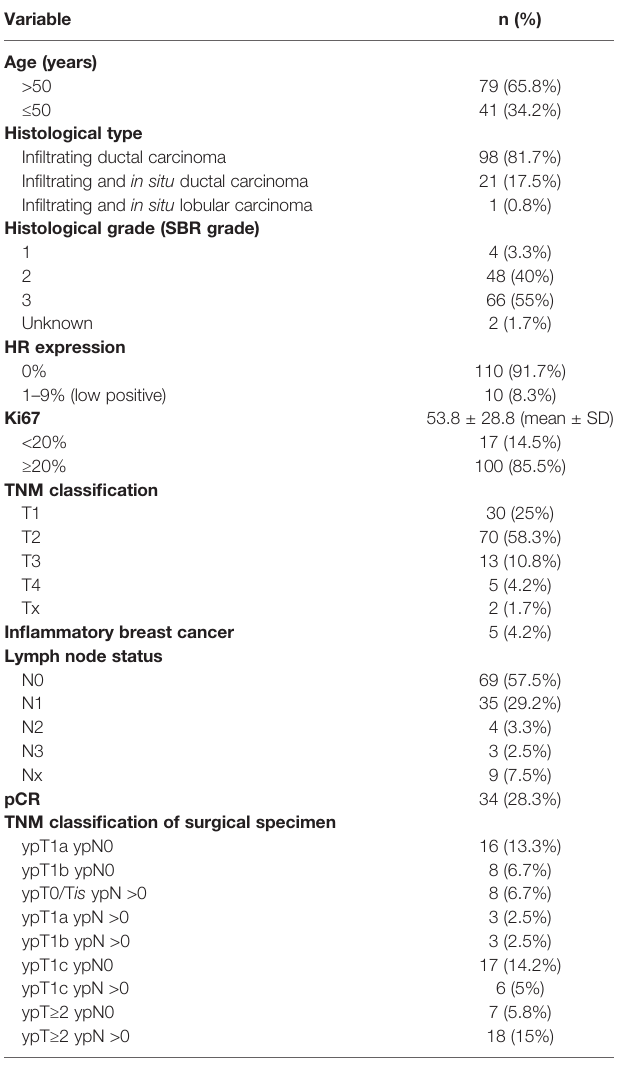
TABLE 1 | Patient baseline characteristics (n =